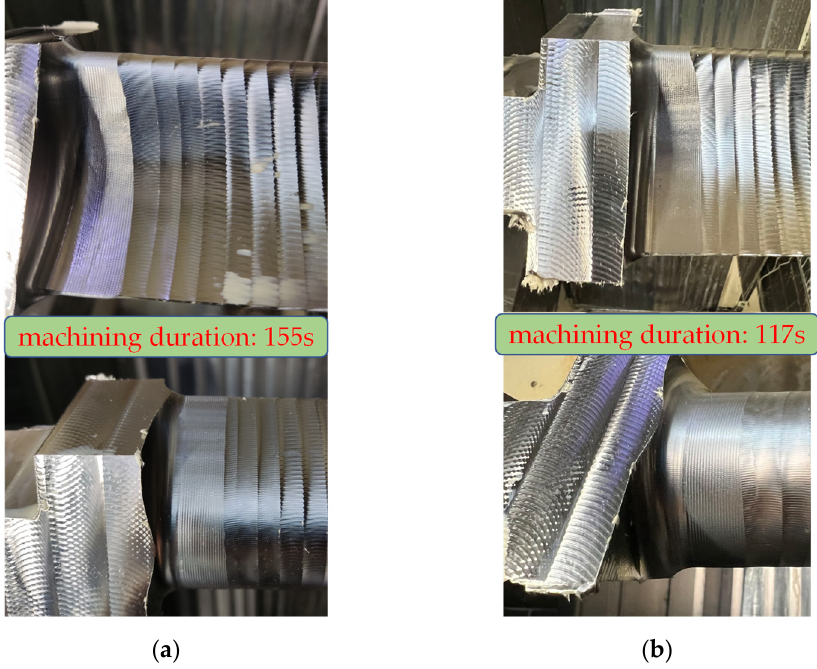
Figure 18. Results of experimental tests. ( a ) Original method; ( b ) the proposed